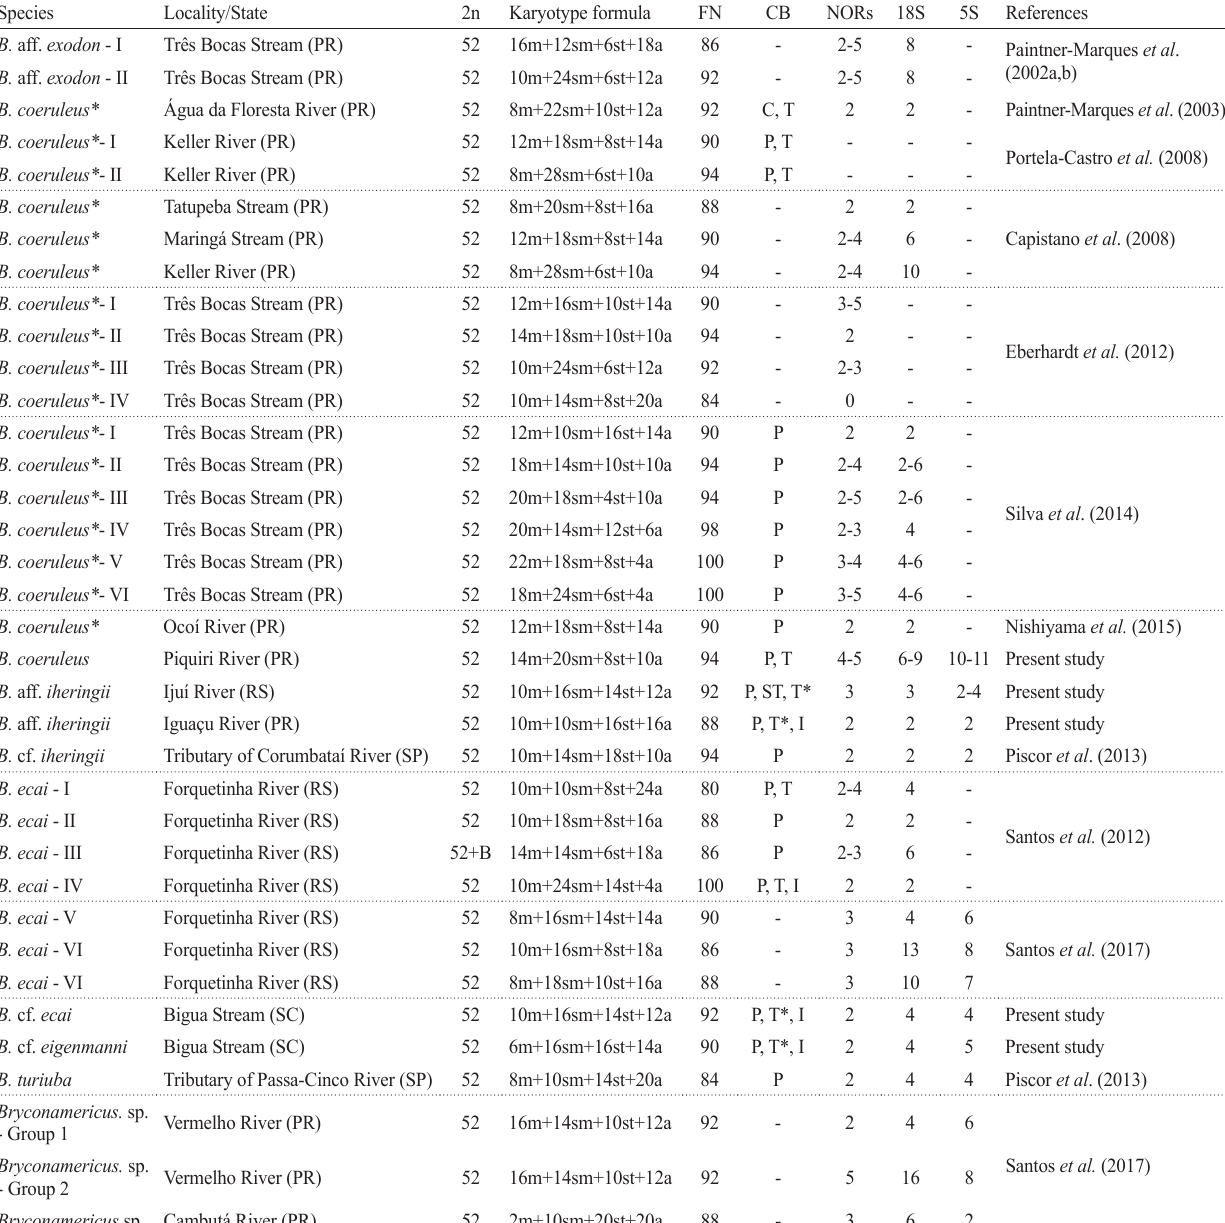
Table 2. Review of cytogenetic data in Bryconamericus . 2n=Diploid number; FN=Fundamental number; CB=C-banding, 18S=18S rDNA cistrons number; 5S=5S rDNA cistrons number; PR = State of Paraná; RS = State of Rio Grande do Sul; SC = State of Santa Catarina; SP = State of São Paulo; *Cited as B. aff. iheringii ; C = Centromeric, I = Interstitial, ST = Subterminal, T = Telomeric, T* =